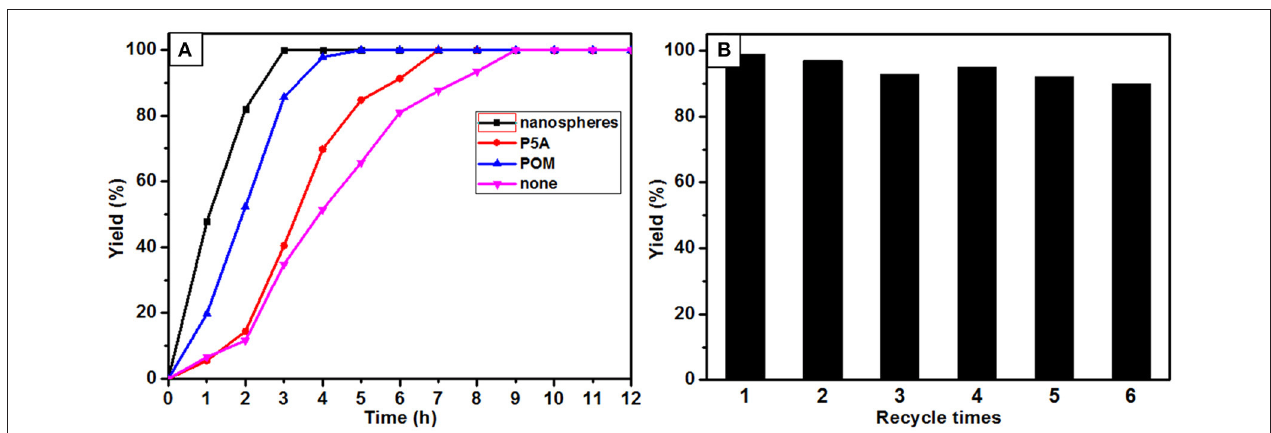
FIGURE 5 | Reaction dynamics (A) and catalytic experiment of recycled of nanospheres (B) .